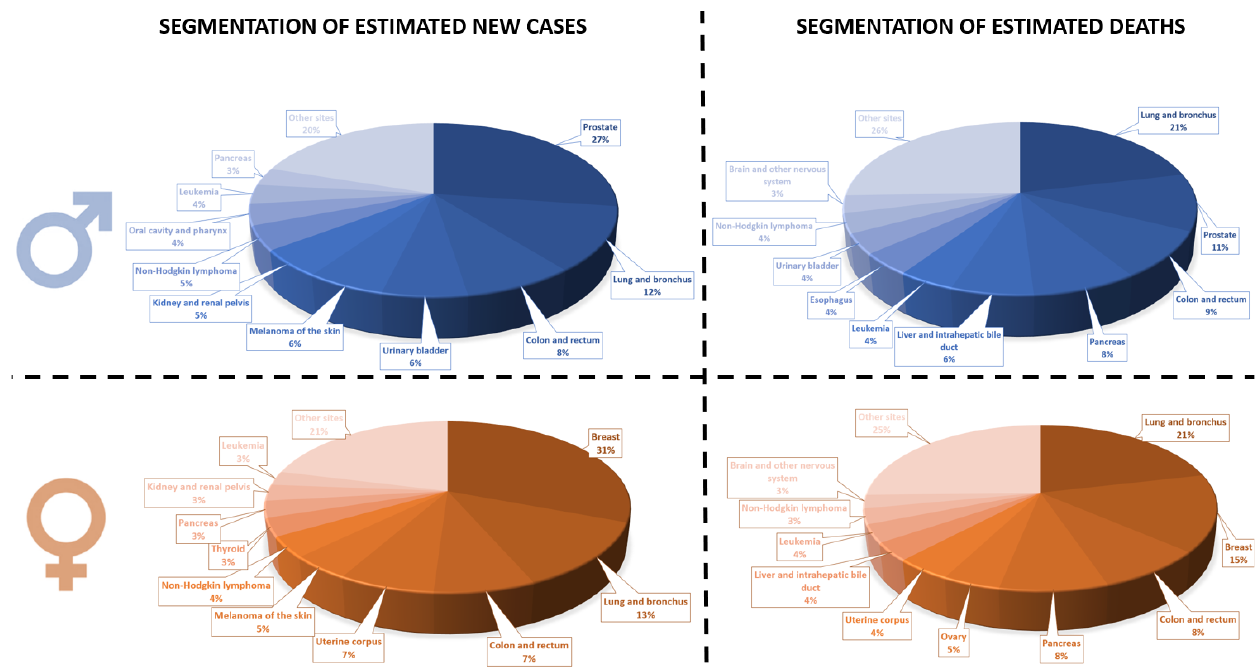
Figure 3. Ten leading cancer types for the estimated new cancer cases and deaths by sex, United States, 2022. Created based on information from [51].